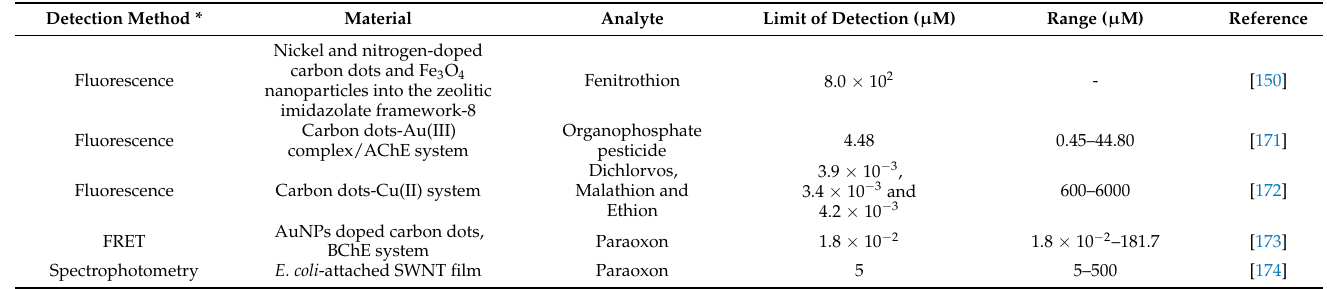
Table 2. Optical sensors for organophosphate detection based on carbon